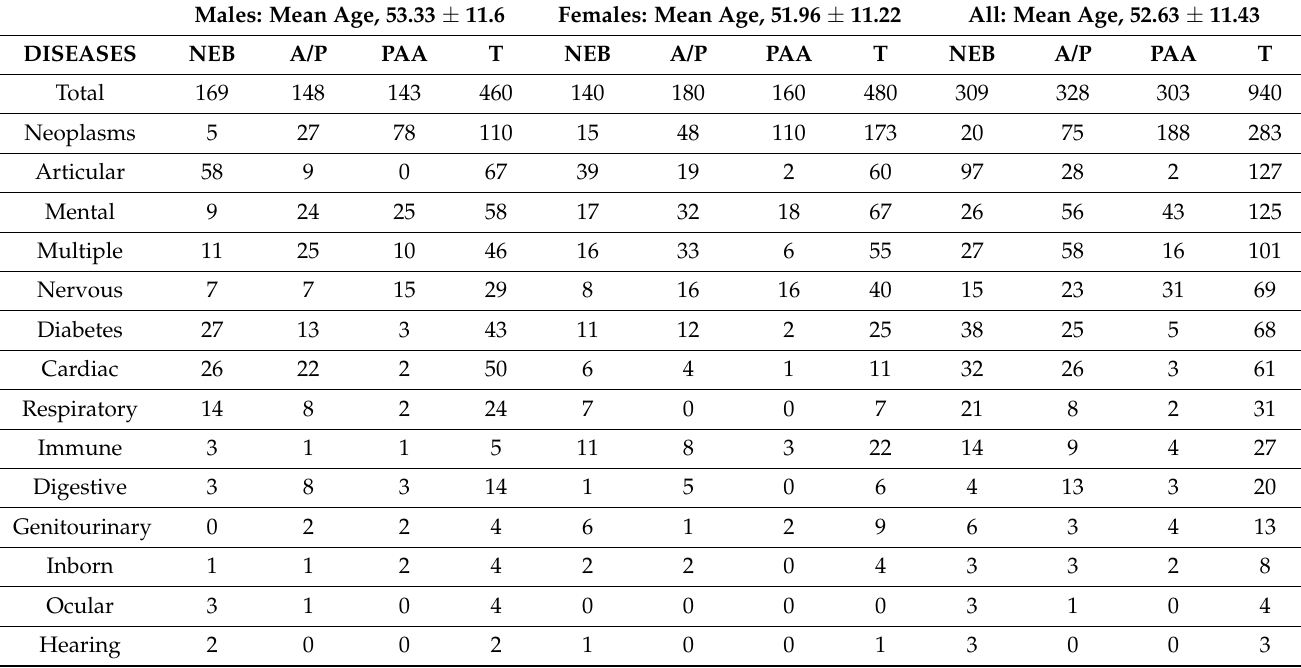
Table 6. Iglesias: civil invalidity in subjects aged 18–65 years in 2021 (January–September). Males: Mean Age, 53.33 ±